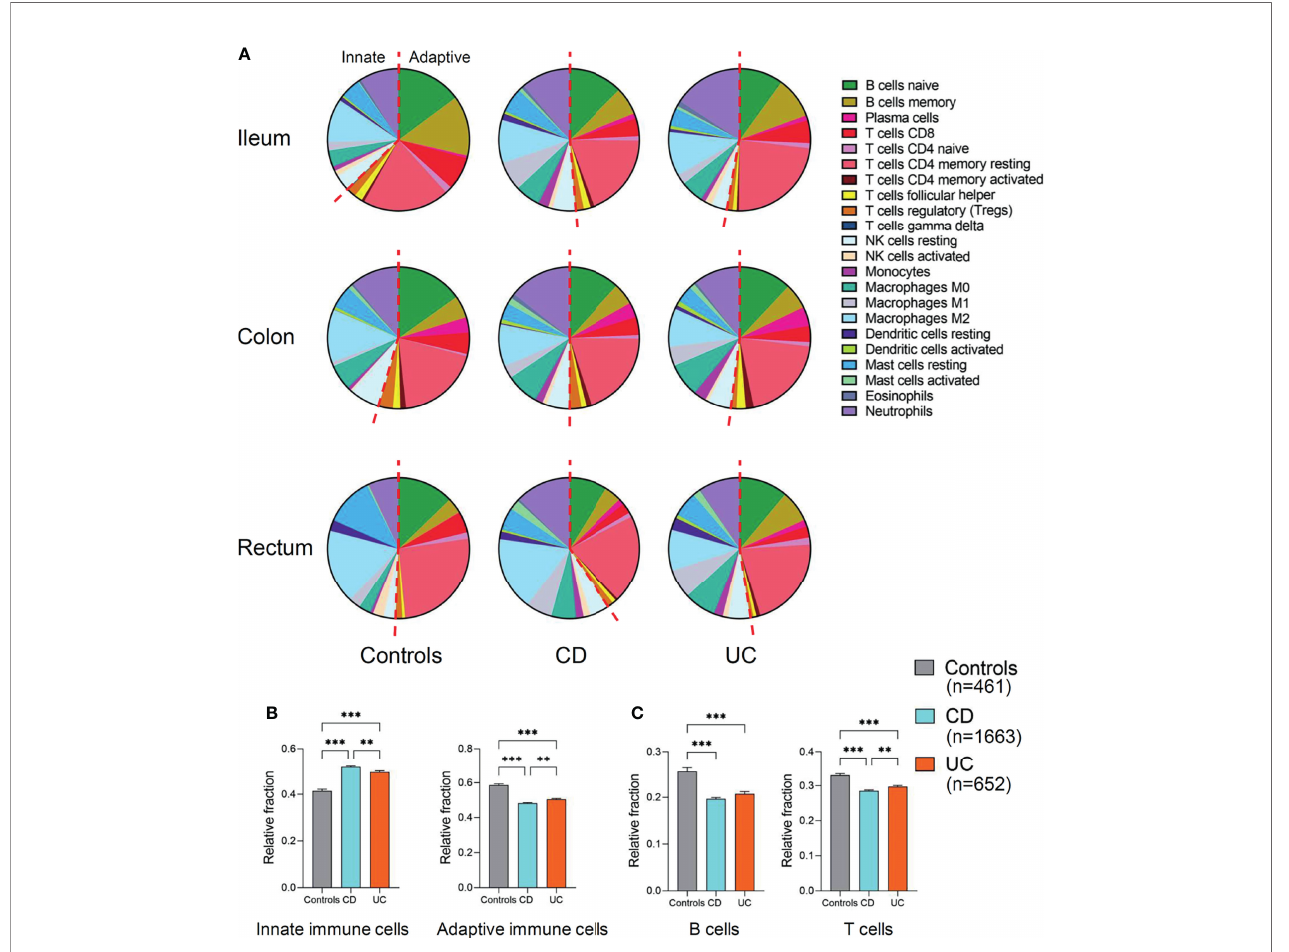
FIGURE 2 | Relative fraction of immune cells pro fi ling in patients with IBD and healthy individuals. (A) Relative fractions of immune cells pro fi ling across three intestinal locations (ileum, colon, and rectum). The left of red dashed line represents innate immune cells and the right of the dashed line represents adaptive immune cells. (B) Comparisons of the total innate immune cells and adaptive immune cells (ileum, colon, and rectum combined) among three disease subtypes. (C) Comparisons of the total B and T cells (ileum, colon, and rectum combined) among three disease subtypes. Statistical signi fi cance was determined by Kruskal – Wallis non-parametric test and Dunn ’ s multiple comparisons test. ** p < 0.01, *** p <